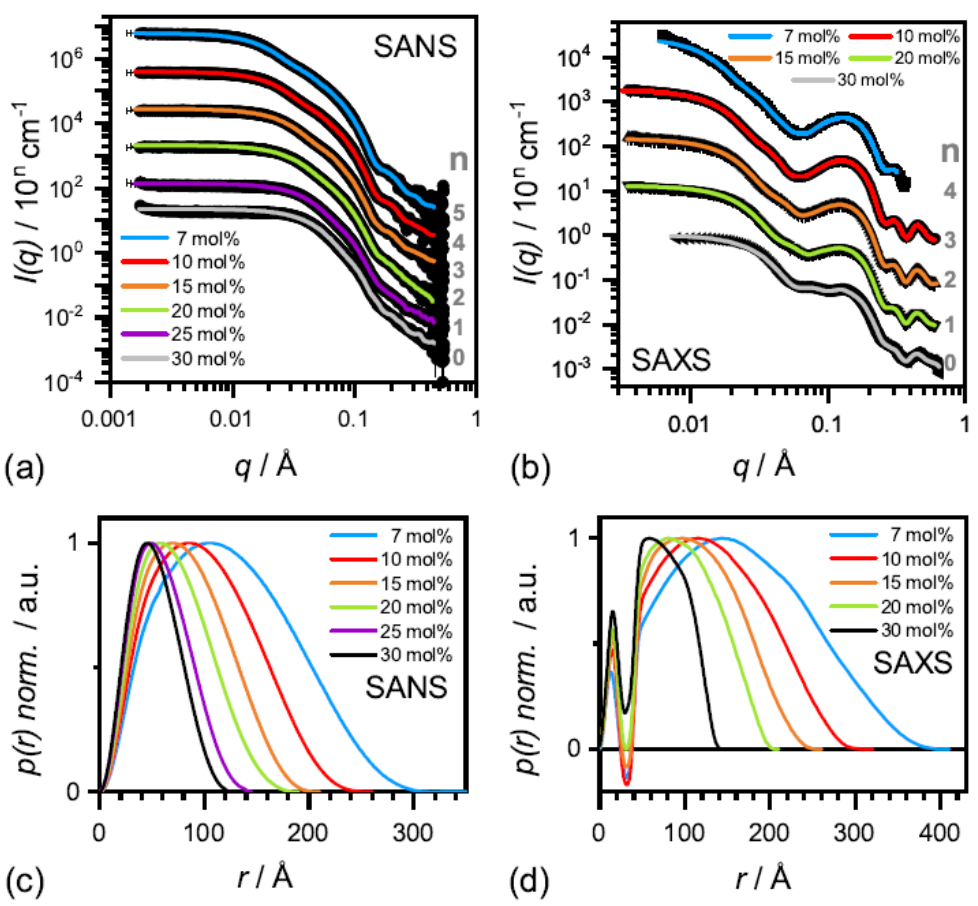
Figure 12. SANS ( a ) and SAXS ( b ) curves of β -aescin stabilized bicelles at 10 ◦ C for different aescin concentrations. The solid lines are fits obtained by using the IFT method developed by O. Glatter. ( c ) Normalized spatial correlation functions p ( r ) from SANS and ( d ) from SAXS from the respective panels ( a ) and ( b ). The legend indicates the β -aescin content in mol% with respect to the amount